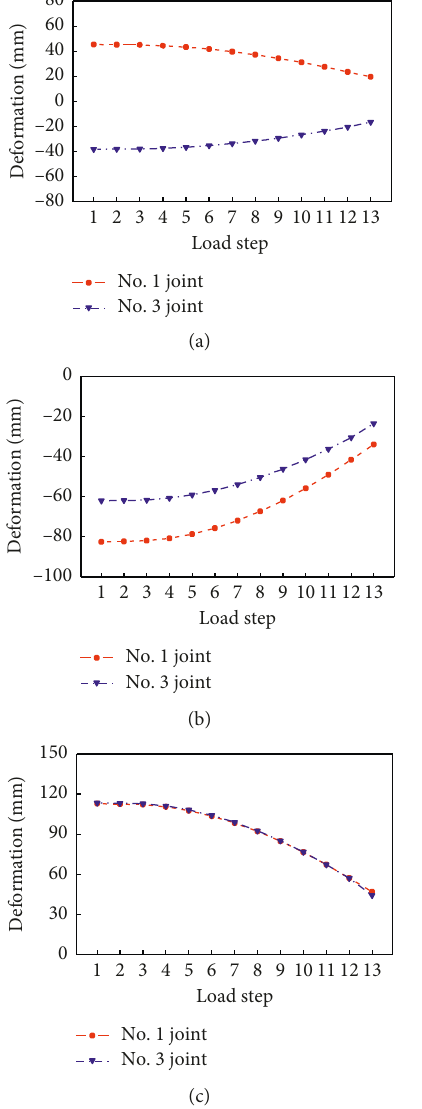
Figure 19: Calculated results of joint deformation. (a) X direction. (b) Y direction. (c) Z